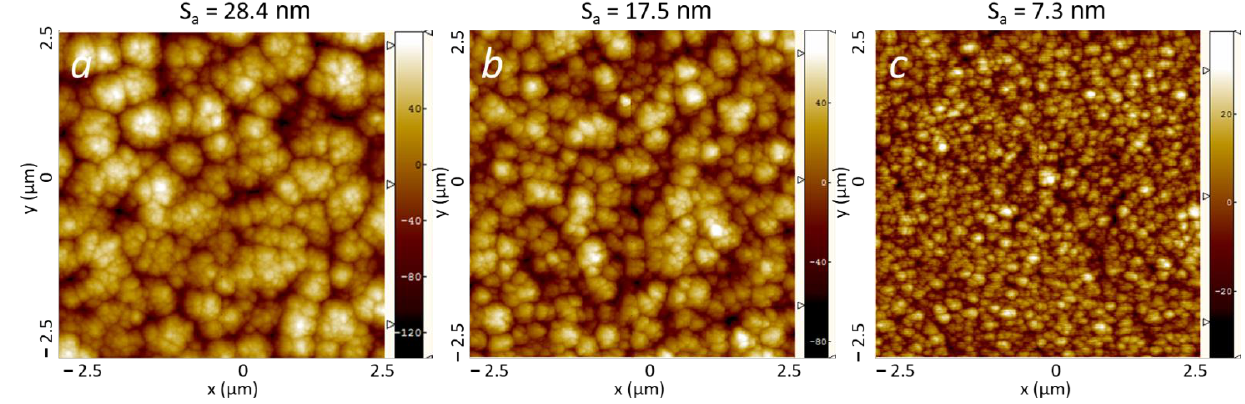
Figure 8. AFM images (scan area 5 µm × 5 µm) show the surface morphology of the NL-TiAlN/CrN hard coating sputter deposited on D2 tool steel substrates. The samples were prepared in the same batch but rotated around a different number of axes: ( a ) one-fold, ( b ) two-fold and ( c ) three-fold rota- tion.